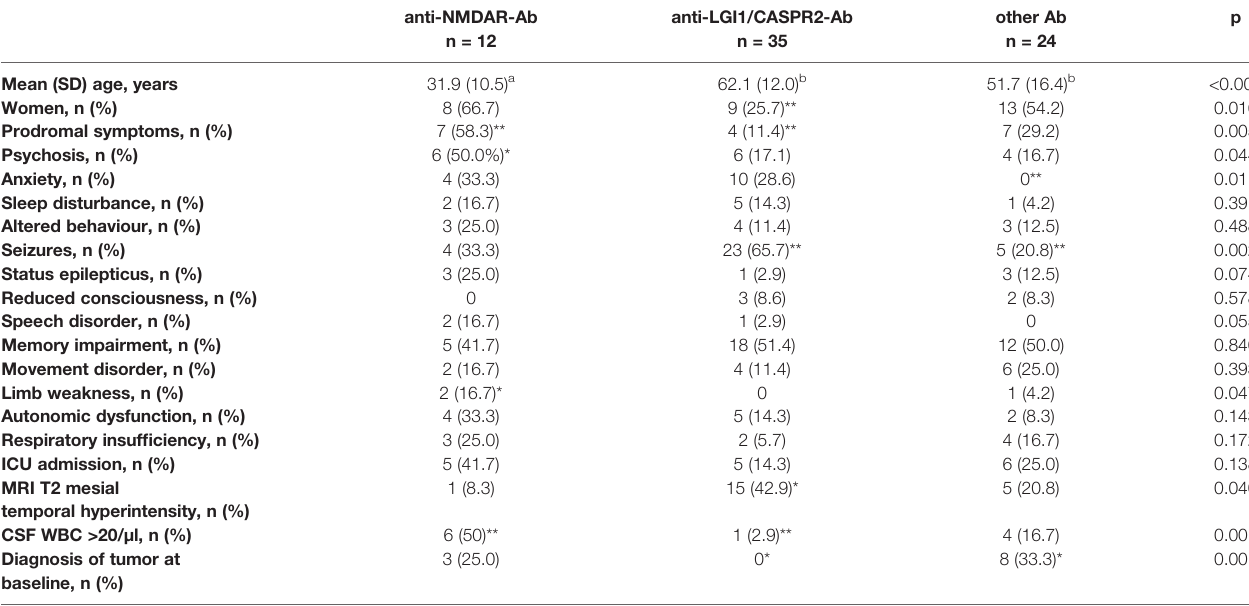
TABLE 1 | Demographic, clinical and paraclinical data of patients at baseline strati fi ed according to their antibody status.